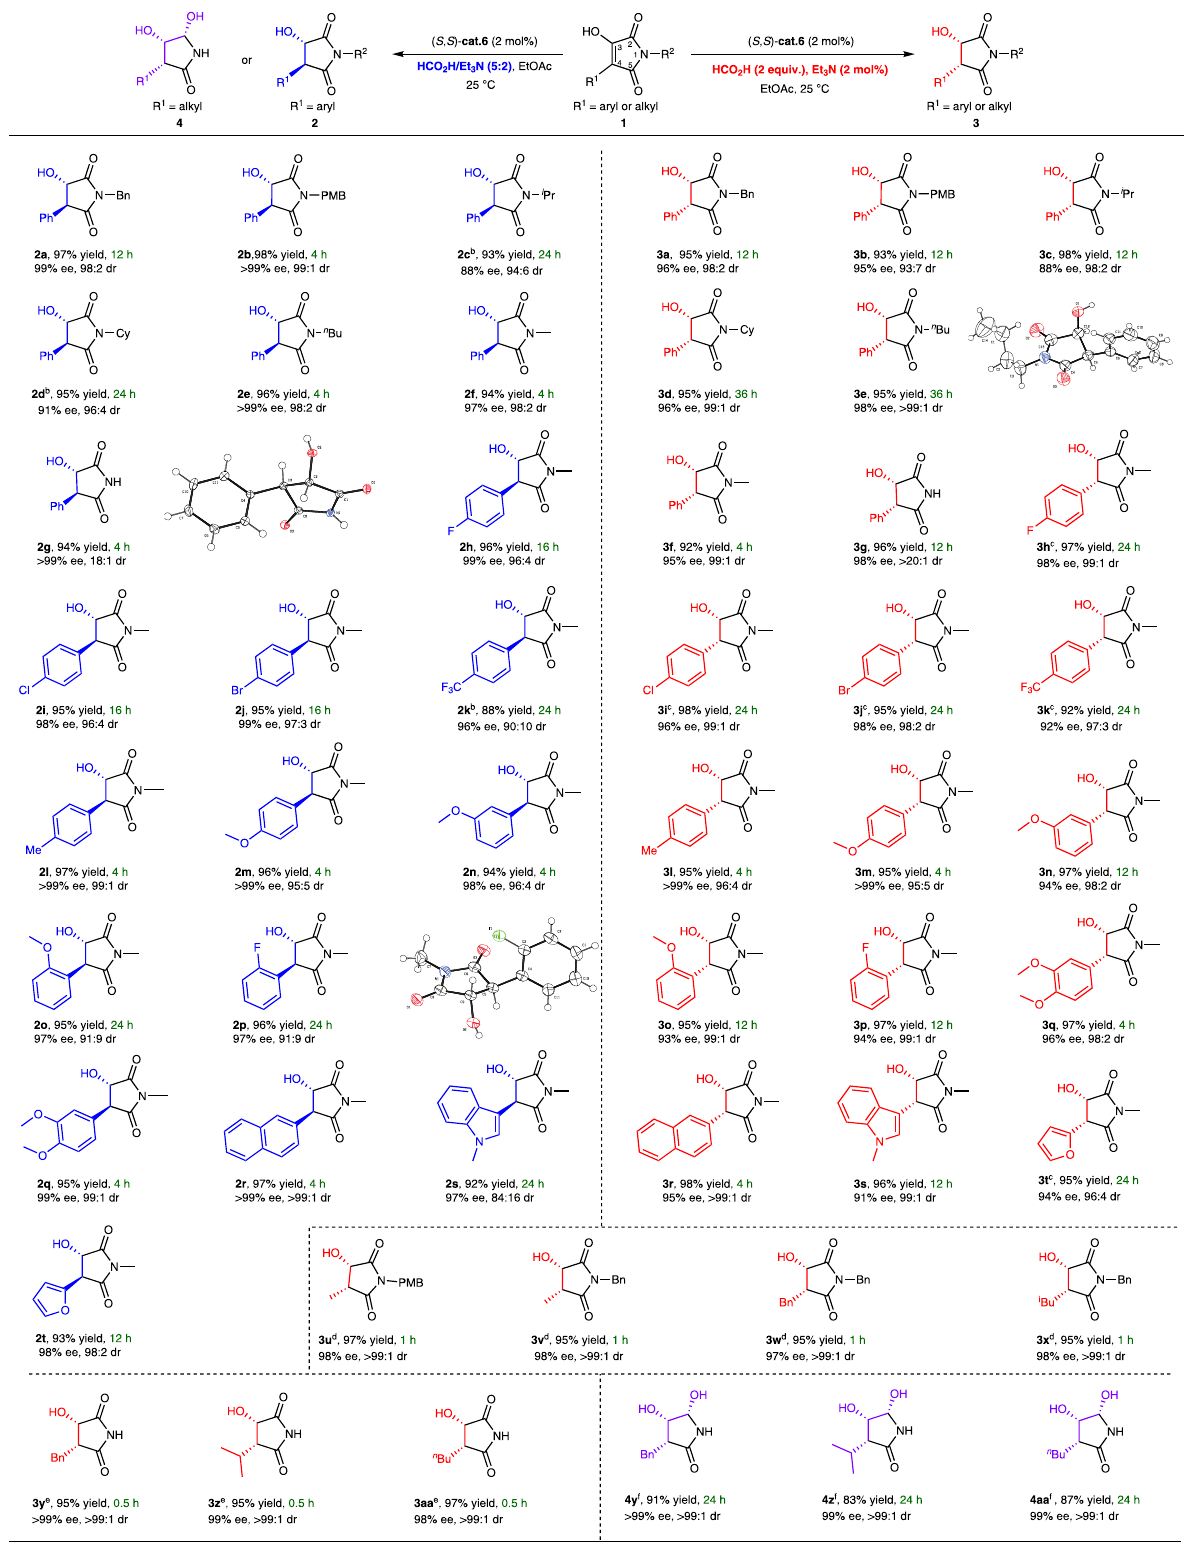
Fig. 3 | Substrate scope. a Conducted with catalyst/substrate (0.2 mmol) ratio of 1: 50 in 1 mL of solvent, HCO 2 H (2.0 equiv.)/Et 3 N (2 mol%) for syn – isomer 3 and HCO 2 H/Et 3 N azeotropic mixture (20 μ L) obtained anti – isomer 2 . Isolated yield including the minor enantiomer, the ee and dr value of were deter- mined by HPLC analysis using a chiral stationary phase. b ( S , S )- cat.6 (5 mol%)